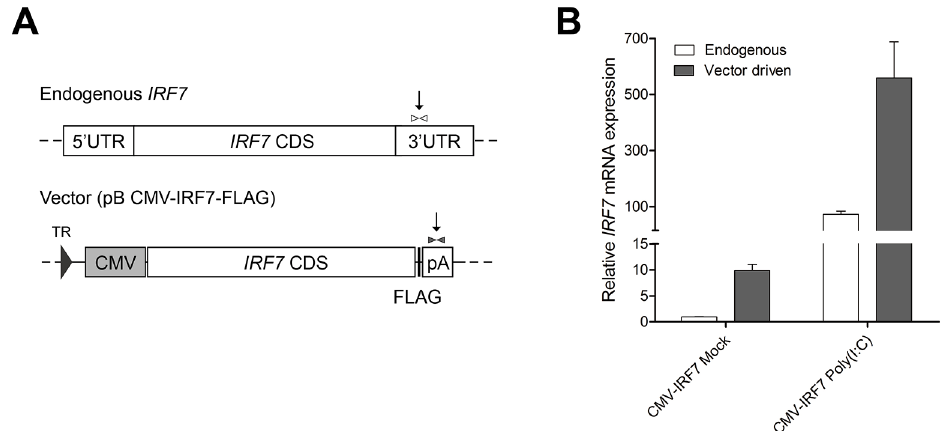
Fig 7. Characterization of IRF7 expression in the overexpression cell line. (A) Two different primer sets, specific to each endogenous or vector driven gene, were designed in the downstream region of the IRF7 CDS to differentiate between native versus construct driven expression. The locations of primers are indicated as arrow lines. (B) Relative quantitation differentiation of IRF7 expression in the mock or poly(I:C) stimulated overexpression cell lines. Error bars indicate the SEM of triplicate